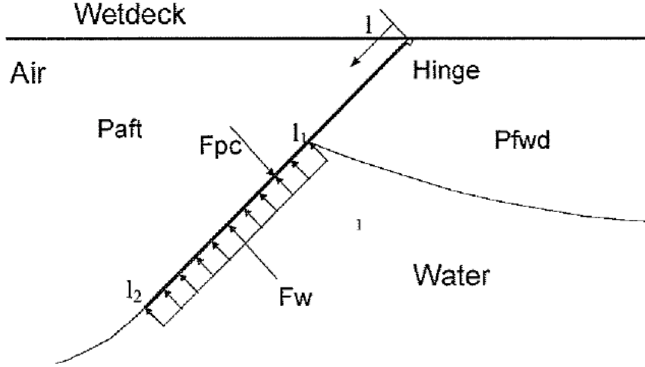
Figure 11. Force diagram sketch of the seal.